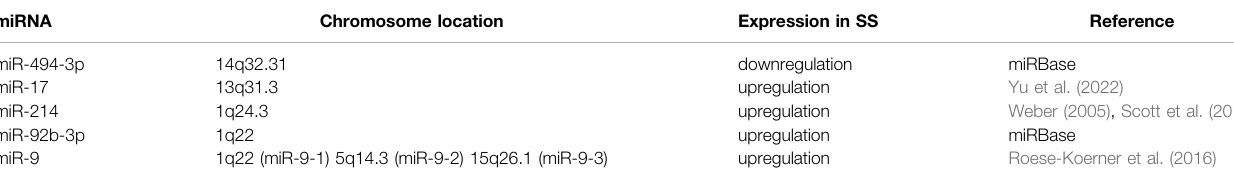
TABLE 1 | The Regulation Expression in SS and the Location on Chromosome of MiRNA.